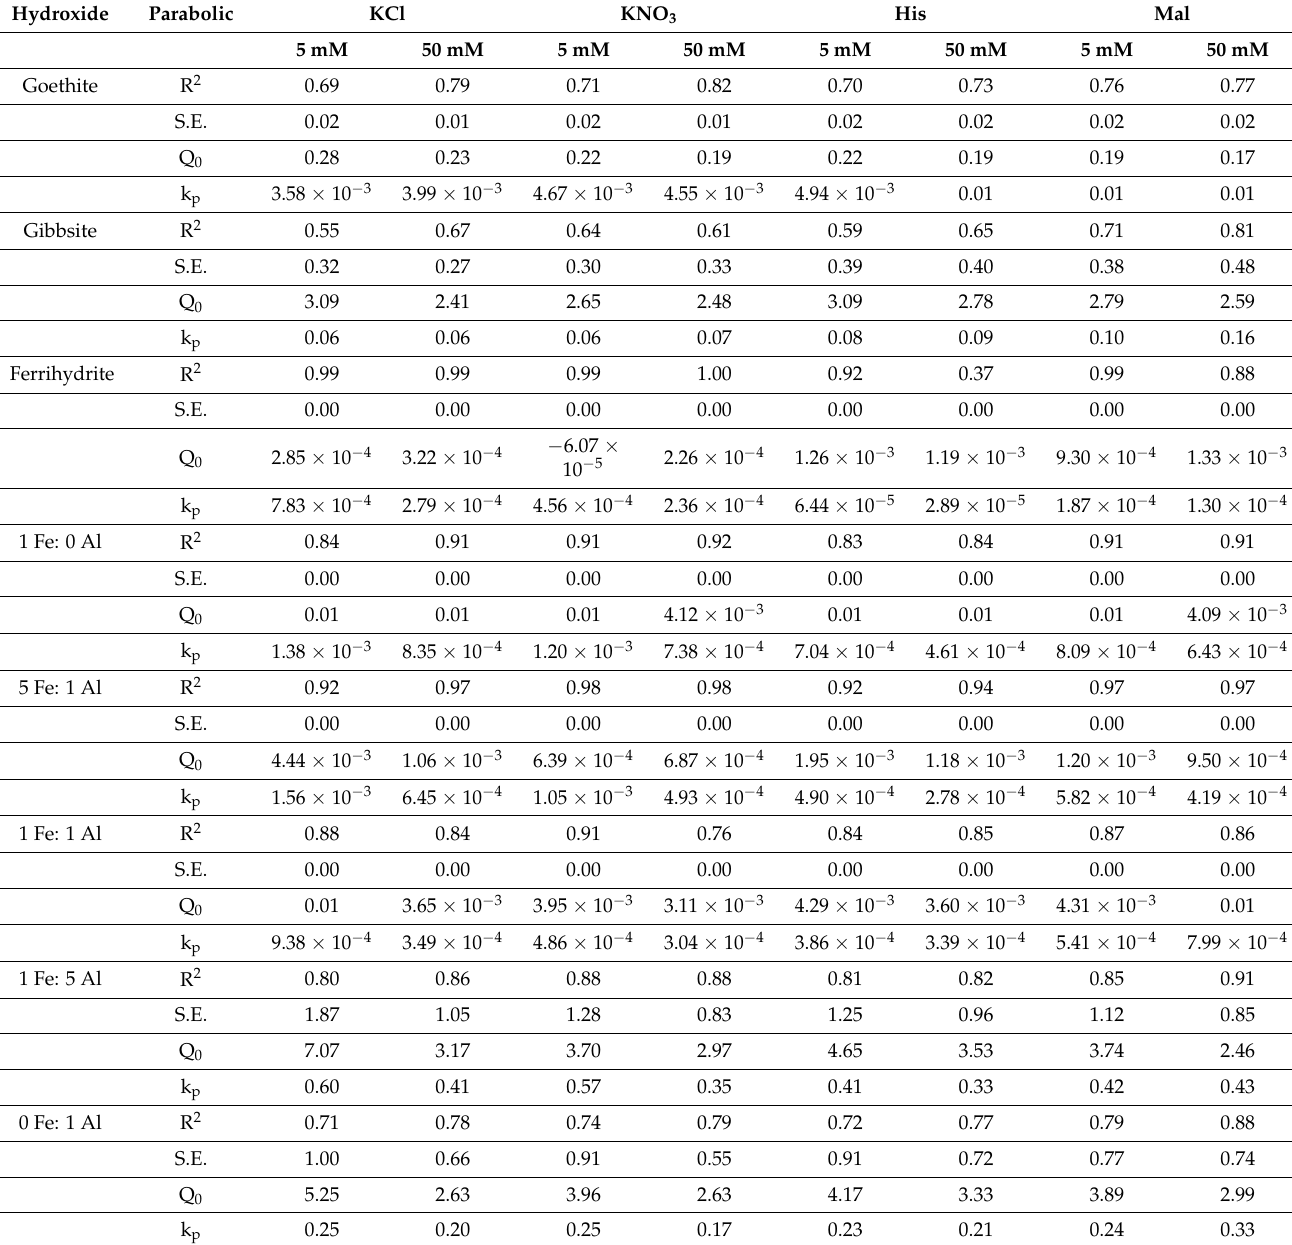
Table 6. Coefficients of determination (R 2 ), standard error (S.E.), and calculated kinetic parameters for the parabolic function used to describe the kinetic release of P after 336 h desorption